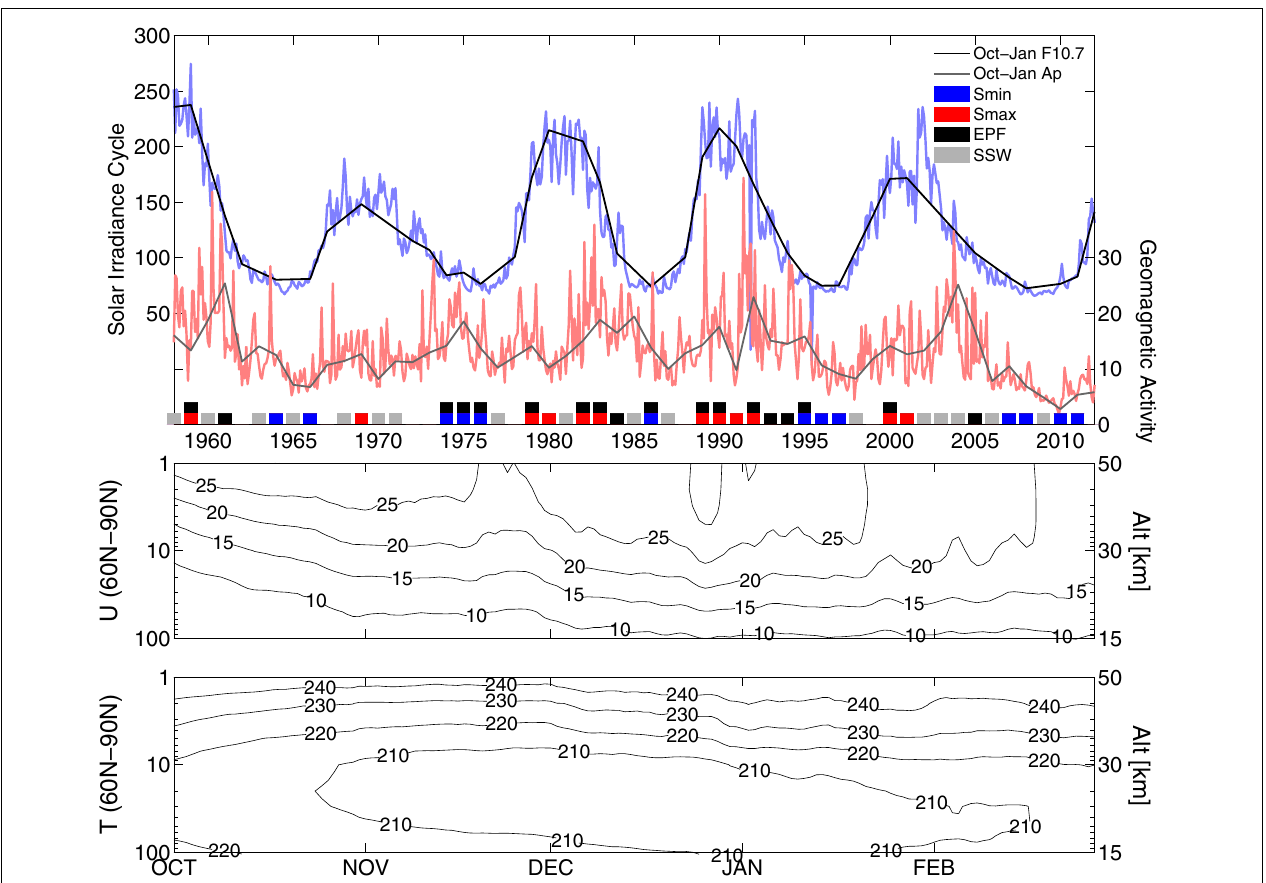
FIGURE 1 | Top: Progression of the Solar Irradiance Cycle (Solar F10.7cm radio flux) and variation in EPF (A p index) from 1958 to 2012. Monthly means are shown for both F10.7 (blue), and A p (red). Oct–Jan means for both are also presented. The winters identified as solar minimum (Smin), solar maximum (Smax), and high EPF, as described in the text, are shown as colored bars. The gray bars indicate an occurrence of a midwinter SSW